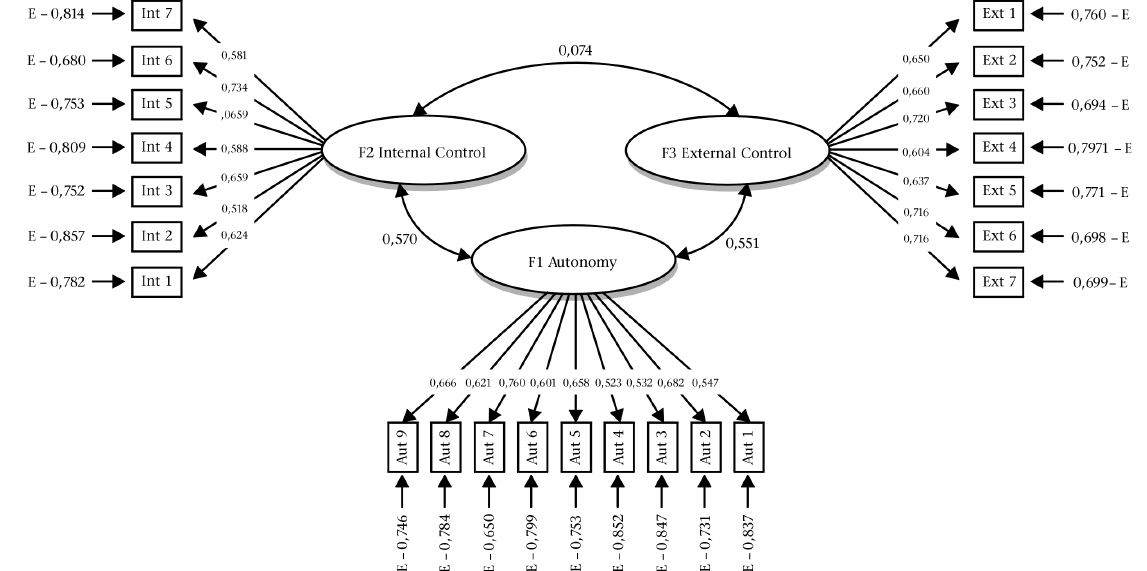
Figure 5: Standardised estimated parameters of the three-factor LCI model for first language respondents